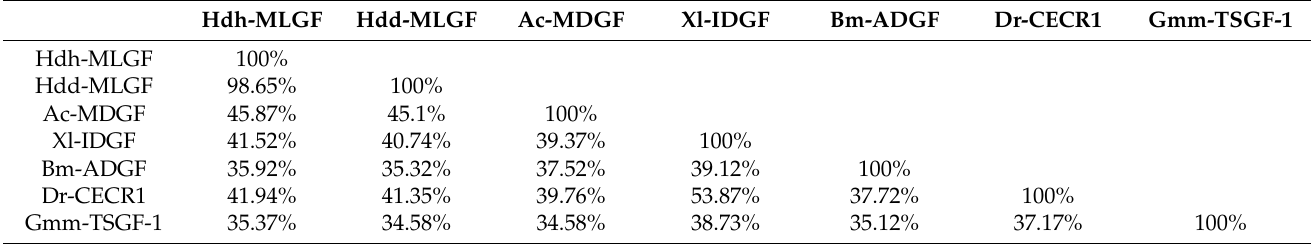
Table 2. Amino acid percent identity of Hdh-MLGF compared with other members in the ADGF